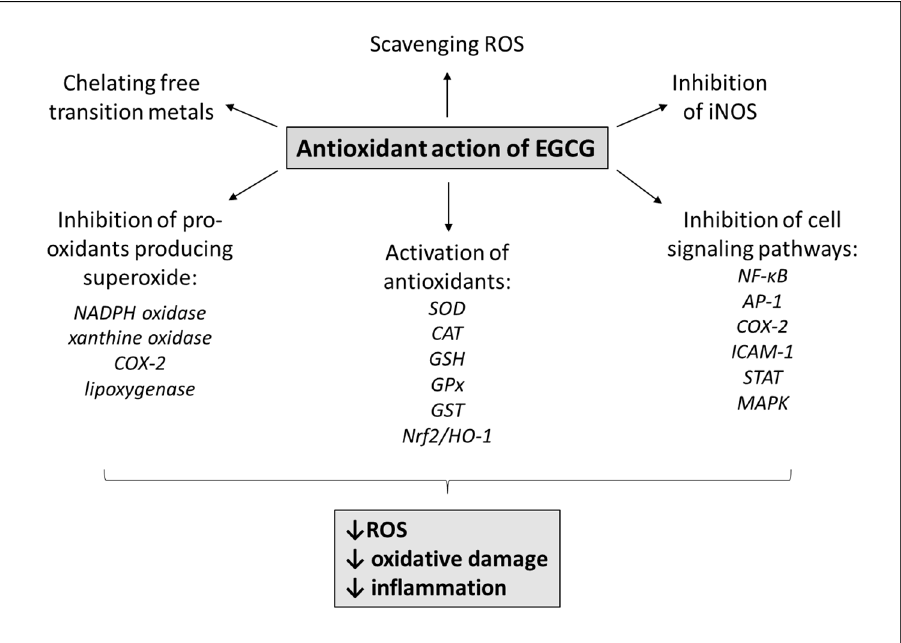
Figure 2. Antioxidant action of EGCG. Abbreviations: AP-1 : activator protein 1, CAT : catalase, COX-2